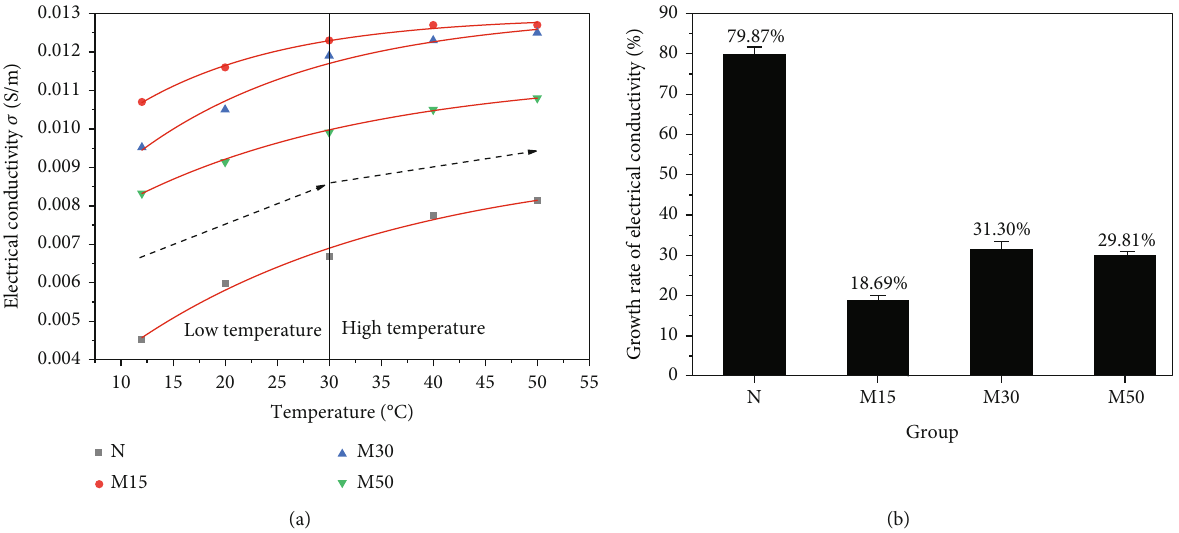
Figure 7: (a) Variation of electrical conductivity of MWCNTs/CM with temperature. (b) The growth rate of electrical conductivity at 50 ° C.